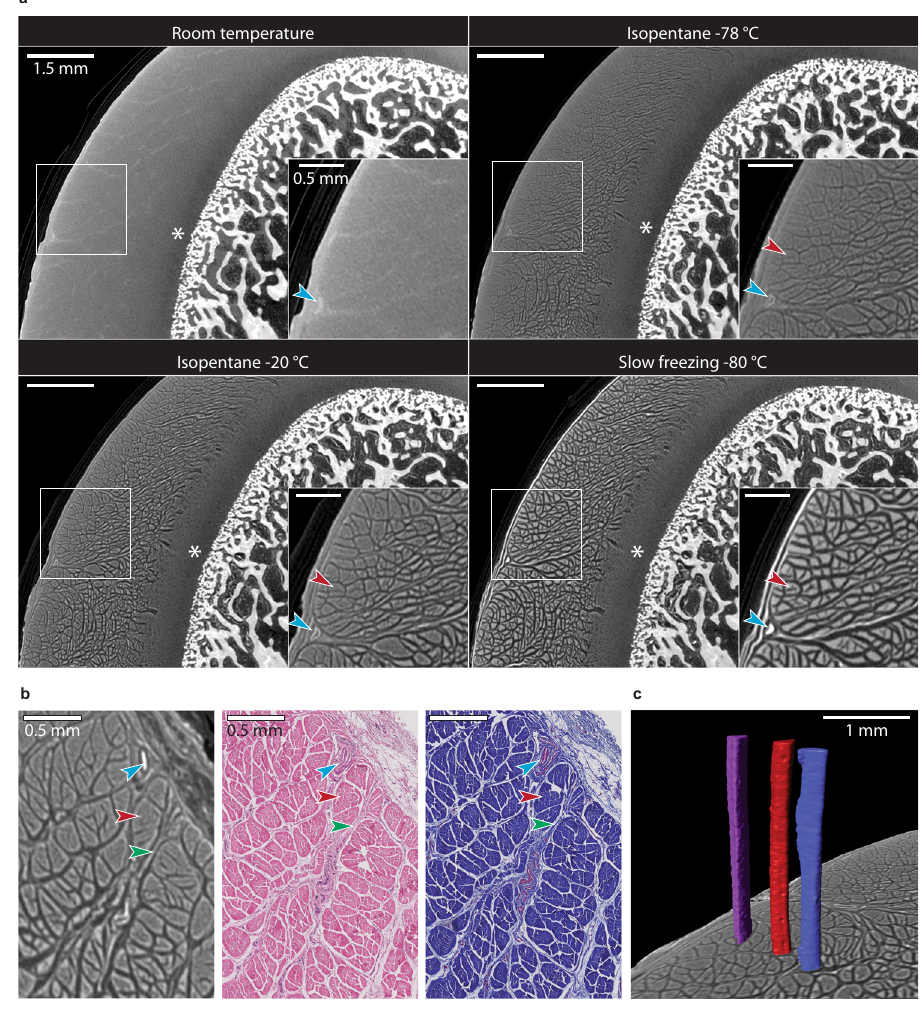
Fig.3|The3Dvisualizationofindividualcollagen fi bersinthetendontissueat the porcine Achilles bone-tendon interface for different freezing rates. a Transverse microCT slices, perpendicular to the collagen fi bers ’ direction, of the porcine Achilles bone-tendon ( n =1) stained with Hf-WD POM, obtained by con- ventional CECT (room temperature) or by cryo-CECT using different freezing methods: submersion in isopentane at − 78°C, submersion in isopentane at − 20°C or slow-freezing in air at − 80°C. A magni fi cation (white square) is shown in the inset. The arrows indicate an individual collagen fi ber in the tendon tissue (red